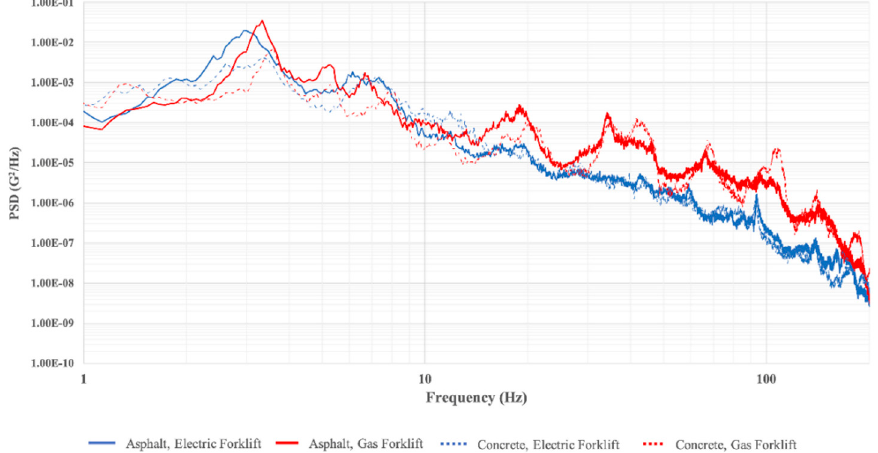
Figure 9. PSD plots of the three investigated forklifts as a function of road roughness (concrete and asphalt).